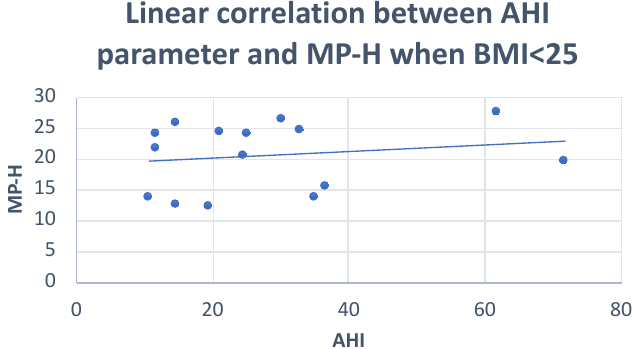
Figure 3. Scatter plot defining the relationship between AHI and MP-H distance. r = 0.29.